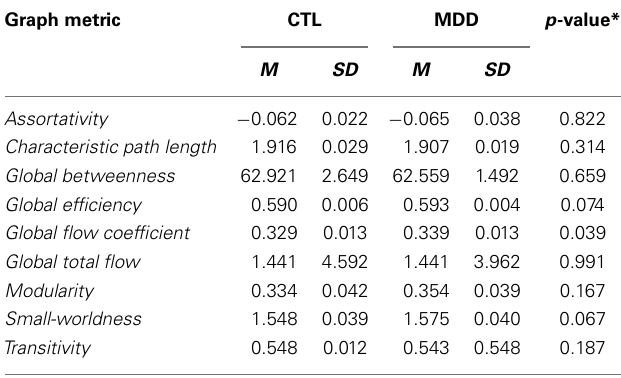
Table 4 | Univariate results comparing graph metrics between groups .